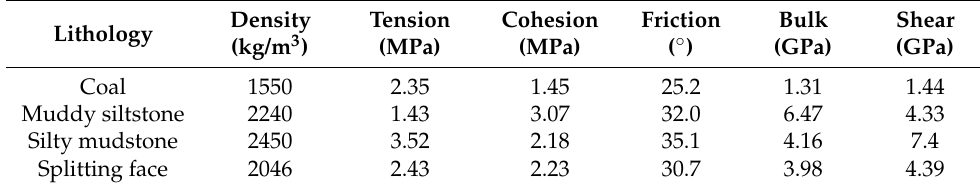
Table 1. Mechanical parameters of rock